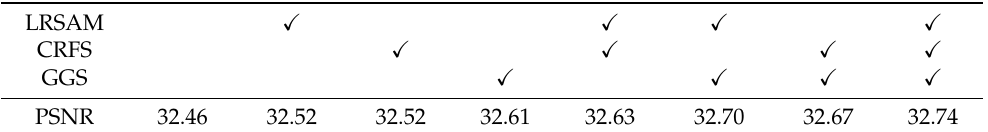
Table 3. Investigations of LRSAM, CRFS, and GGS. We observe that the proposed GPSR, that is, the model that uses LRSAM, CRFS, and GGS simultaneously, achieves the best super-resolution performance on Set5 dataset with scaling factor ×